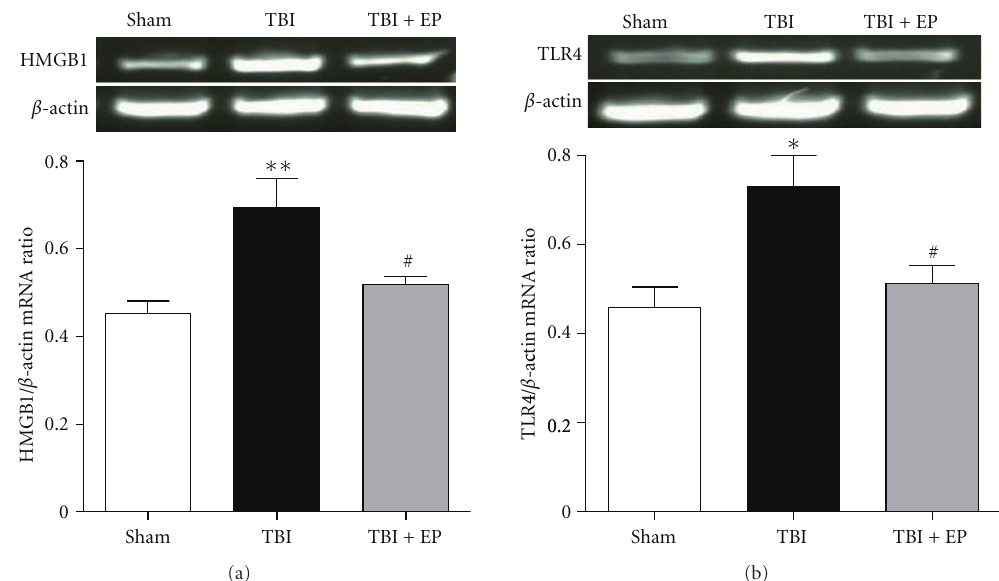
Figure 4: HMGB1 and TLR4 mRNA expression in the rat brain of the Sham group, TBI group, and TBI + EP group. Upper panel: representative RT-PCR bands show the HMGB1 and TLR4 mRNA expression in each group. Bottom panel: density of mRNA bands from each group. Quantitative analysis of the RT-PCR results for the expression of HMGB1 and TLR4 mRNA. It shows that TBI induced a marked increase of HMGB1 and TLR4 mRNA expression in the brain tissue surrounding the contusion cortex compared with the Sham group ( P < . 01). After treatment with EP, the HMGB1 and TLR4 mRNA expressions were significantly downregulated compared to the TBI group ( P < . 05). Bars represent as mean ± SEM; n = 6, each group; ∗∗ P < . 01, ∗ P < . 05 versus Sham group, # P < . 05 versus TBI group.